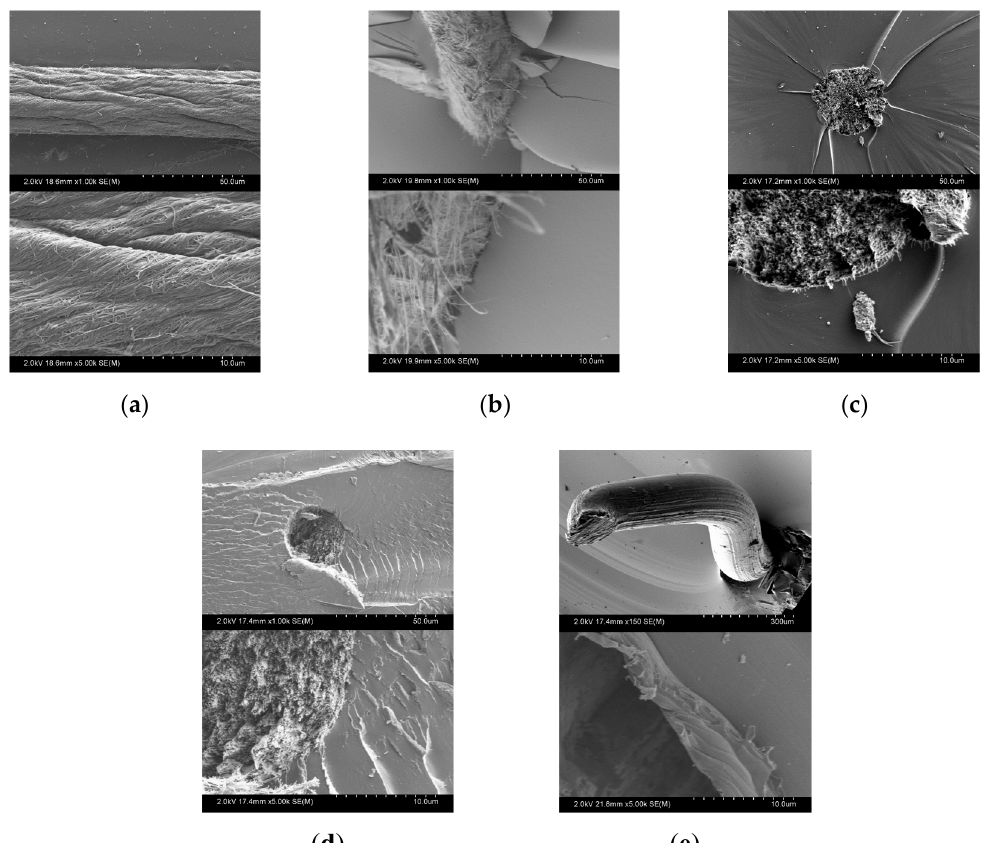
Figure 9. SEM images (1000×, above and 500×, below) of CNTY and CNTY/polymer specimens. ( a ) Individual CNTY, ( b ) CNTY/ER-A, ( c ) CNTY/ER-B, ( d ) CNTY/ER-B-RT, ( e ) CNTY/ER-B-50.